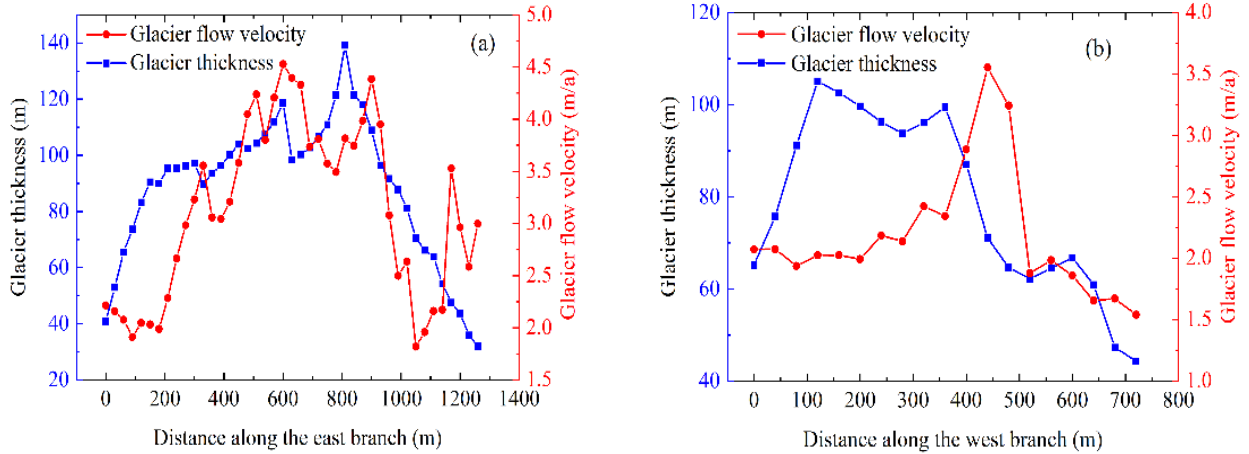
Figure 12. Glacier thickness and 3D velocity of the centerline in the east branch ( a ) and west branch ( b ).